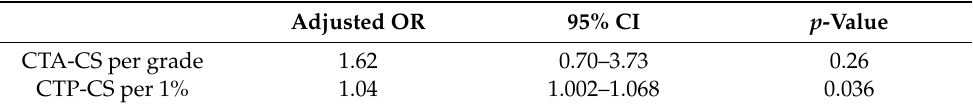
Table 3. Adjusted Odds Ratio of logistic regression models of CTA-CS and CTP-CS for favorable outcome.